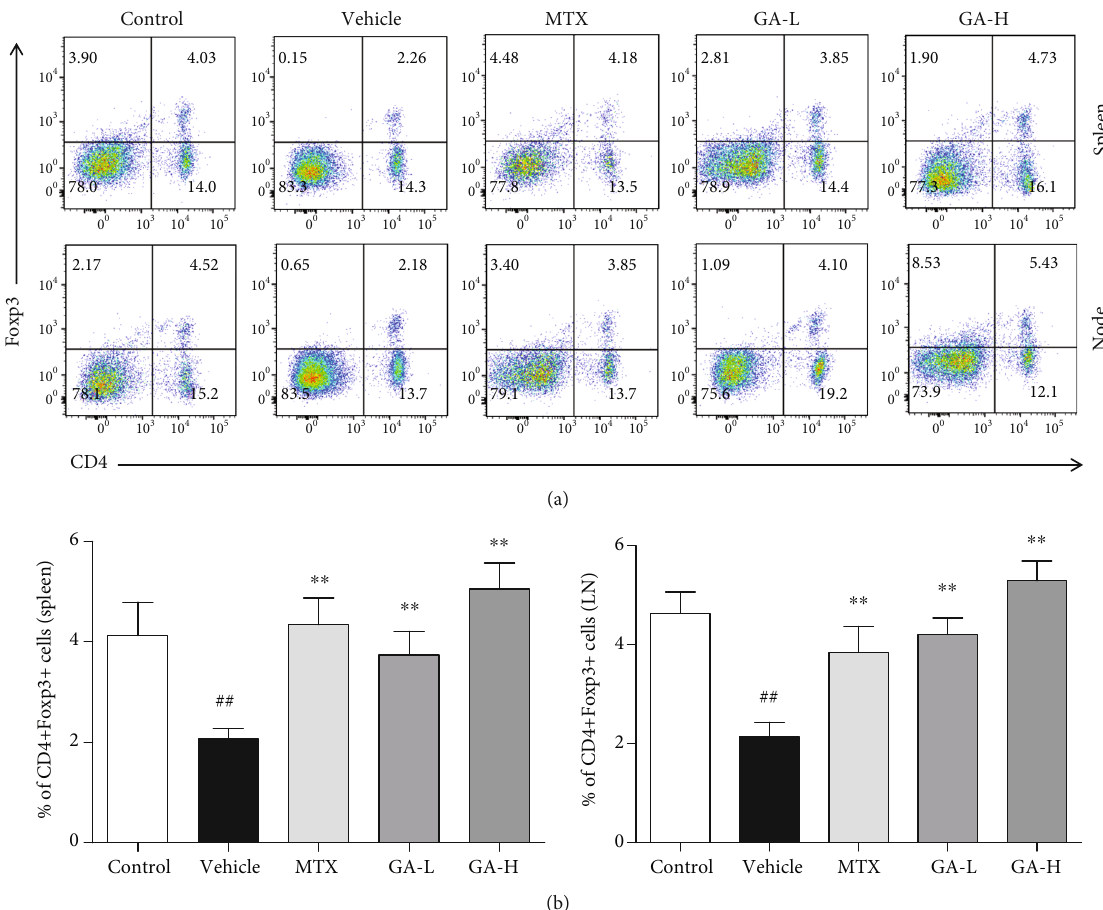
Figure 5: GA induces CD4+Foxp3+ Tregs in imiquimod-induced psoriasis-like mice. E ff ects of GA on CD4+Foxp3+ Treg frequency in spleens and lymph nodes of IMQ-induced psoriasis-like mice were observed. Spleen and lymph node cells were isolated from imiquimod- induced psoriasis-like mice 7 days after treatment with GA or MTX. To quantify CD4+Foxp3+ Tregs, cells were stained for CD4 surface and intracellular Foxp3 makers. Data shown are the means ± SD ( n = 4 , # P < 0 : 05 and ## P < 0 : 01 compared with control group, ∗ P < 0 : 05 and ∗∗ P < 0 : 01 compared with vehicle